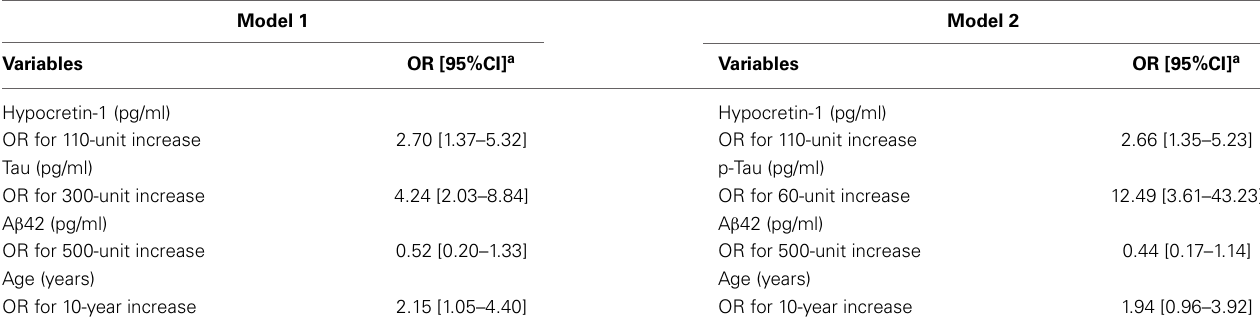
Table 3 | Multivariate logistic regression models of CSF biomarker measurements associated with Alzheimer’s Disease (AD)/Mild Cognitive impairment due to